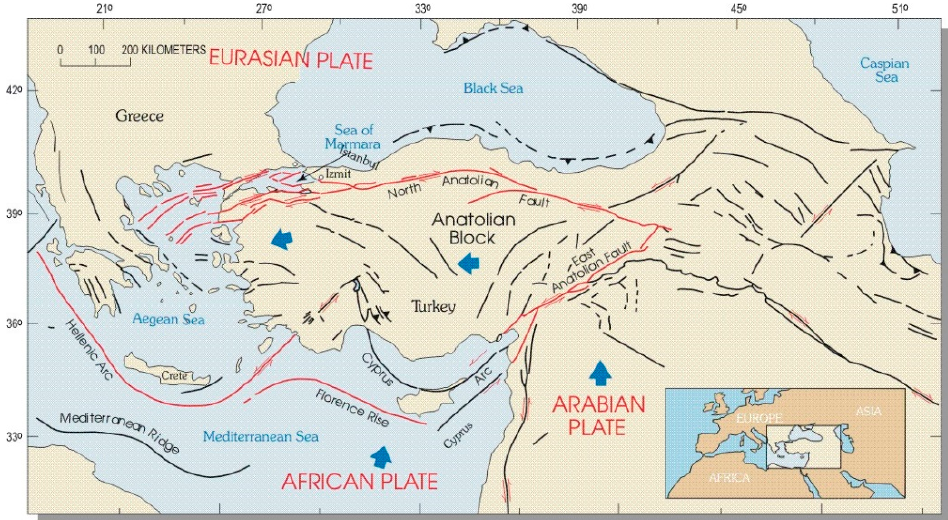
Figure 1. The tectonic map of Eastern Mediterranean Basin, including the North Anatolian fault, East Anatolian fault, and Hellenic and Florence trenches (by U.S. Geological Survey, National Earthquake Information Center—U.S. Geological Survey, National Earthquake Information Center, Public Domain, https://commons.wikimedia.org/w/index.php?curid=33751528 (accessed on 5 December 2022)).